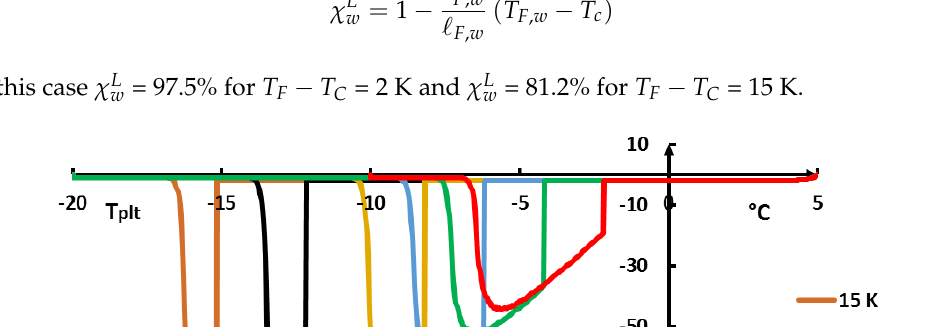
Figure 36. DSC curves for water at the cooling at β =